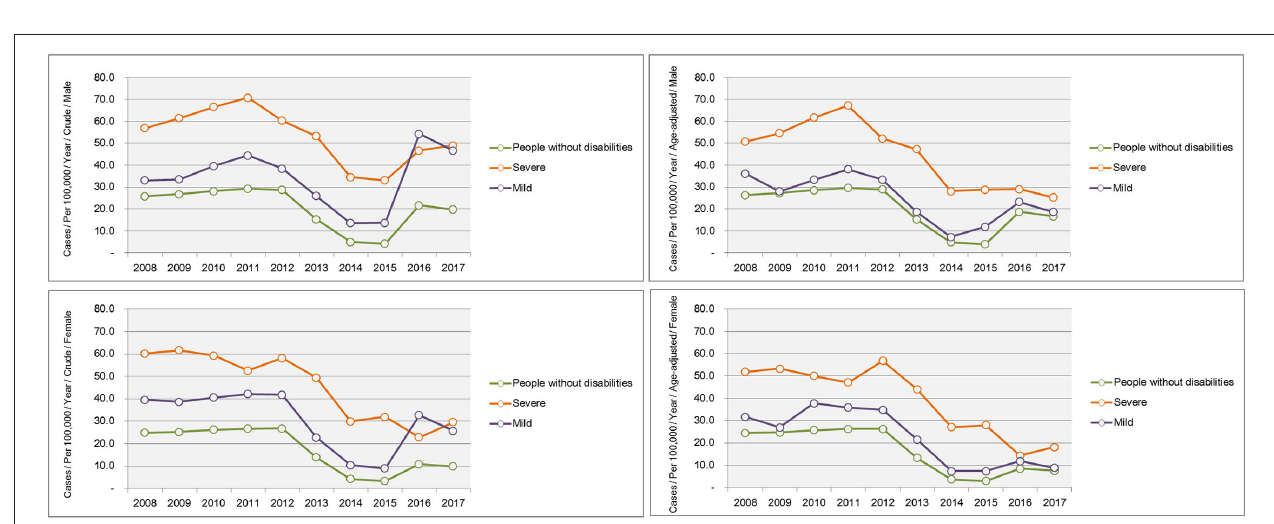
FIGURE 3 | Trends in the incidence of complicated appendicitis according to the severity of a disability for 2008–2017.